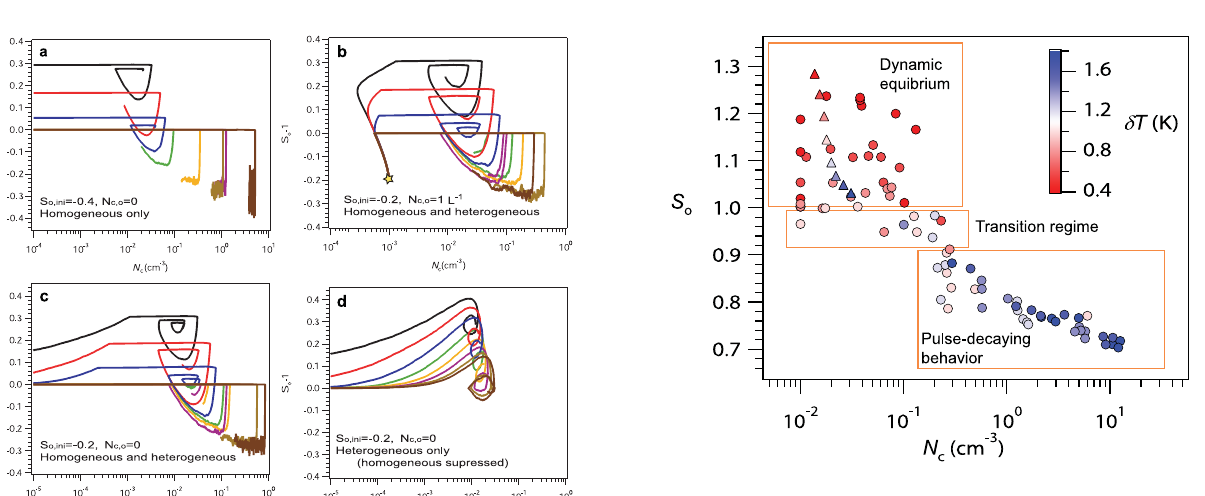
Fig. 9. Maximum ice crystal concentration obtained during the cloud evolution simulations against the time-averaged mean satu- ration ratio. Results presented for all simulations carried out in this study. Integration time varied between 15 and 40h. Symbols are colored by the value of δT used. Regions where the cloud sponta- neously transitions to a “pulse-decay” and “dynamic equilibrium” state are noted; the “transitional” region marks where the cloud gen- erally initially exhibited “pulse-decay” behavior over few hours and then transitioned to a “dynamic equilibrium” regime. ( (cid:13) ) Homo- geneous freezing is active; ( 1) Homogeneous freezing